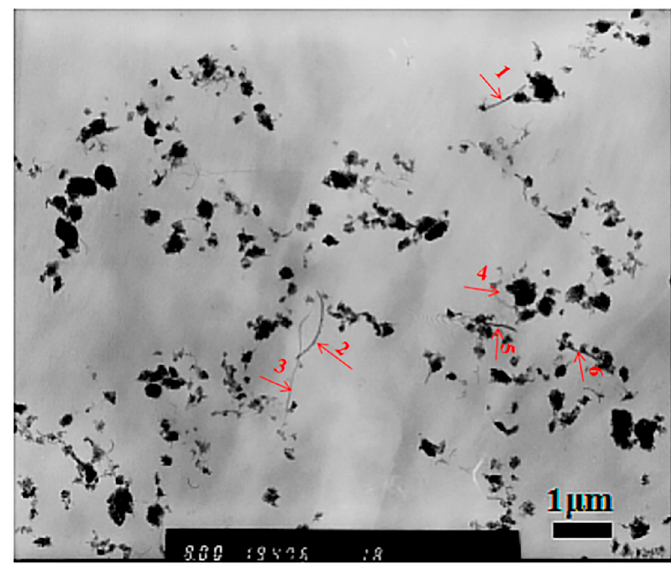
Figure 6. Transmission electron microscopy (TEM) images of drug-loaded MPEG-PDLLA/c-MWCNT nanocomposites prepared with a mass ratio of c-MWCNTs/MPEG-PDLLA of 0.1:1 (tube diameter <8 nm, length 0.5~2 μ m). Table 1. Diameter of c-MWCNTs in drug-loaded MPEG-PDLLA/c-MWCNT nanocomposites